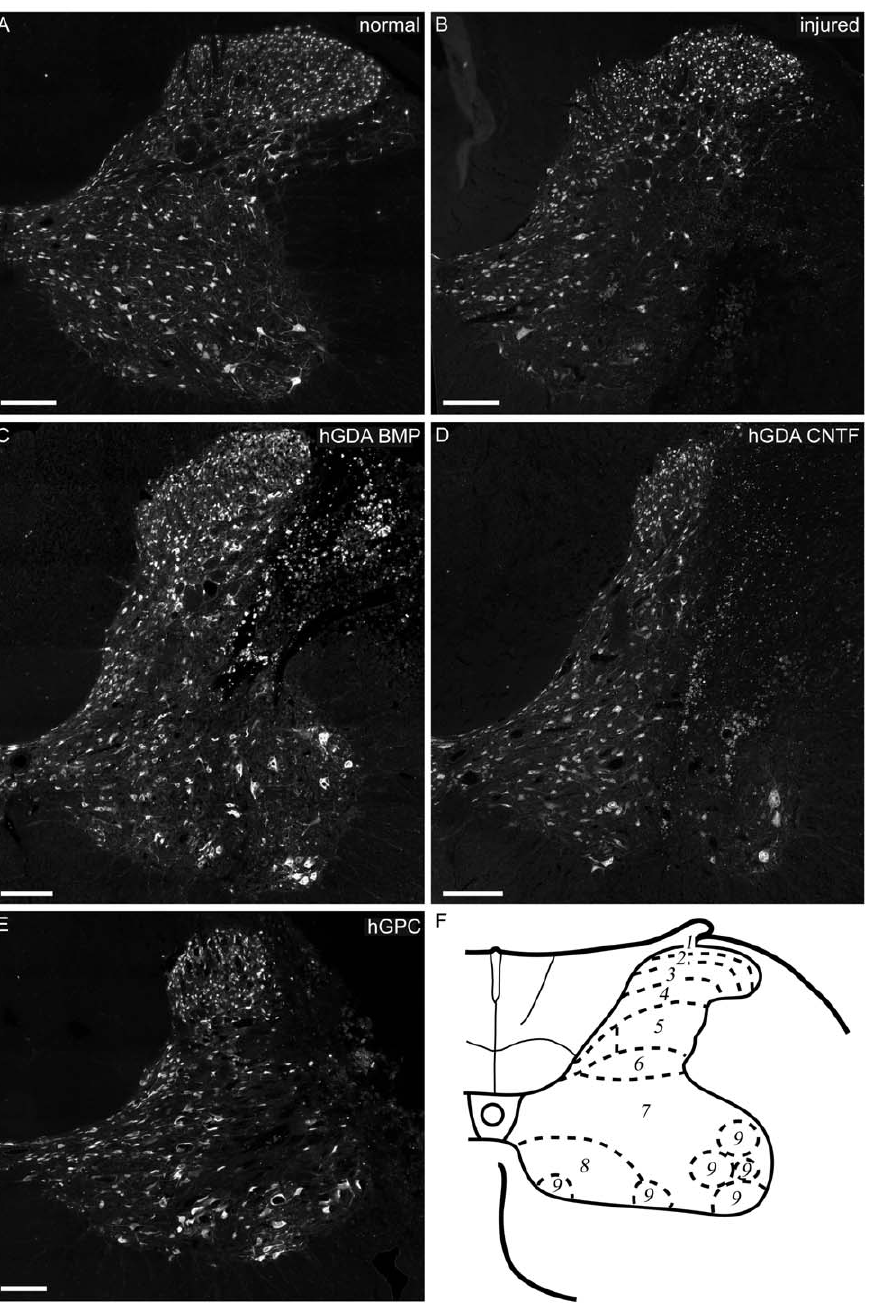
Figure 6. hGDA BMP transplants promote protection of spinal cord neurons while hGDA CNTF and hGPC transplants do not. Montaged images of NeuN immuno-histochemistry at the C5 spinal level of normal (A) and untreated injured (control) spinal cords (B) show that the unilateral DLF transection injury causes loss of NeuN + neurons in multiple spinal cord laminae adjacent to the transected white matter. Transplantation of hGDAs BMP (C) promotes significant protection of neurons in laminae 7, 8, and 9 at the injury center. In contrast, transplantation of hGDAs CNTF (D) or hGPCs (E) did not promote significant levels of neuroprotection. (F) Schematic showing gray matter laminae at the C5 level of the rat spinal cord (adapted from [39]). All scale bars=200 m m. doi:10.1371/journal.pone.0017328.g006 side of the spinal cord: medial and lateral of the rostral and caudal approach in combination with discreet transection injuries of the injury margins, and medial and lateral of the injury center dorsolateral funiculus results in highly consistent deficits in grid- (Supplemental Fig. S1C). Control injured rats were injected with walk locomotor performance [14,57]. 6 m l HBSS. All control or cell transplanted rats were immune suppressed. Rats in the 9W2 groups were given daily injections of cyclosporine (1 mg/100 g body weight) beginning the day before transplanted into six different sites at the injury site on the right